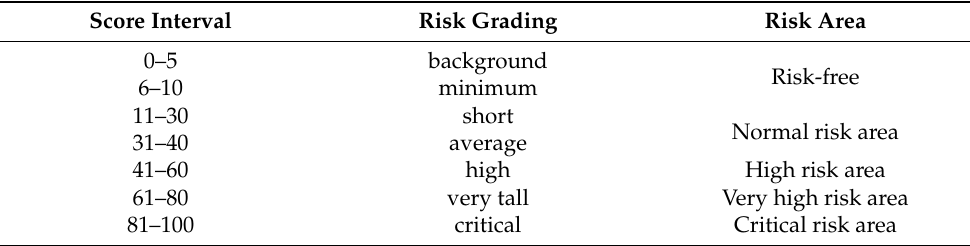
Table 1. Risk grading scale. Score